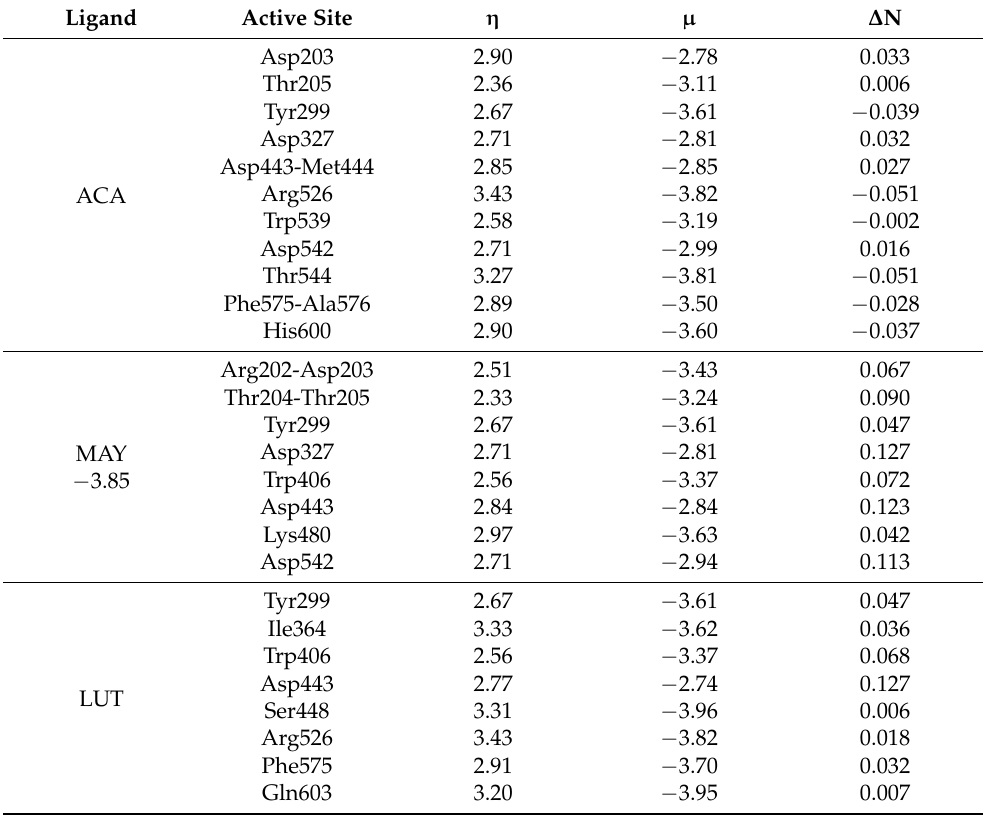
Table 3. Reactivity parameters and charge transfer descriptor calculated for amino acids of the maltase-glucoamylase (NtMGAM) interacting with acarbose (ACA), maysin (MAY), and luteolin (LUT). Chemical hardness ( η ), chemical potential ( µ ), and charge transfer ( ∆ N). The values of η and µ are presented in